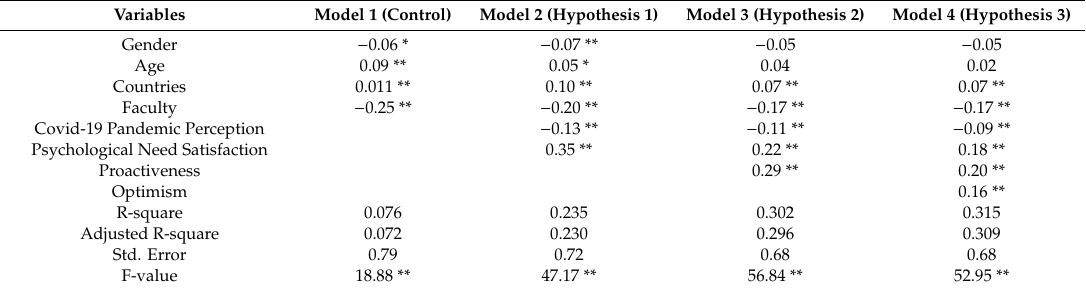
Table 2. Results of regression models—dependent variable = entrepreneurial